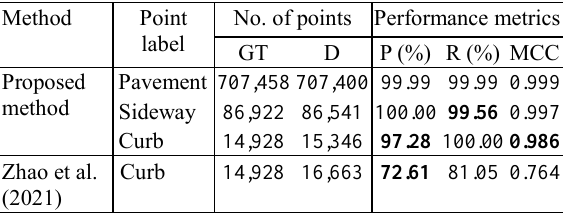
Table 1. Road surface extraction results for Experiment 1.